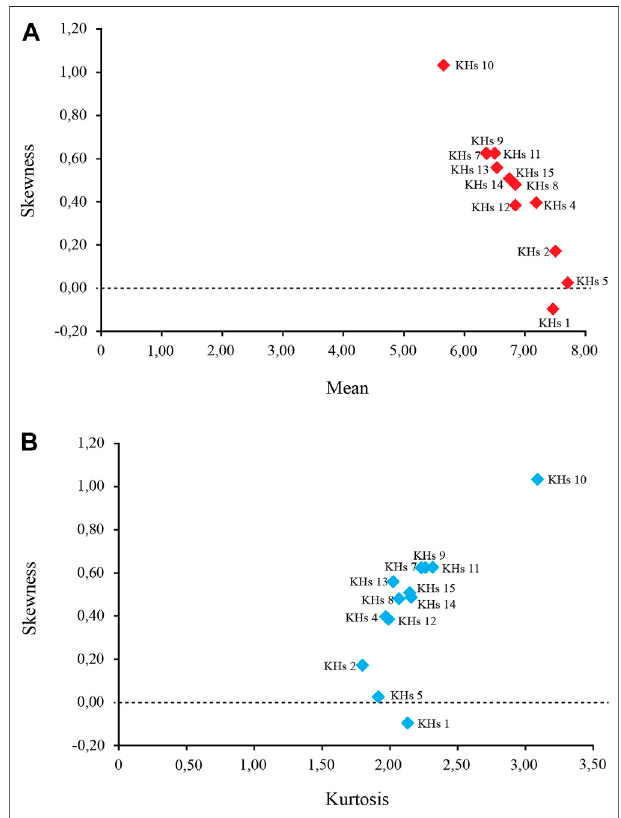
FIGURE 5 | Diagrams comparing indices (in phi), including (A) comparison of mean with skewness and (B) comparison of skewness with